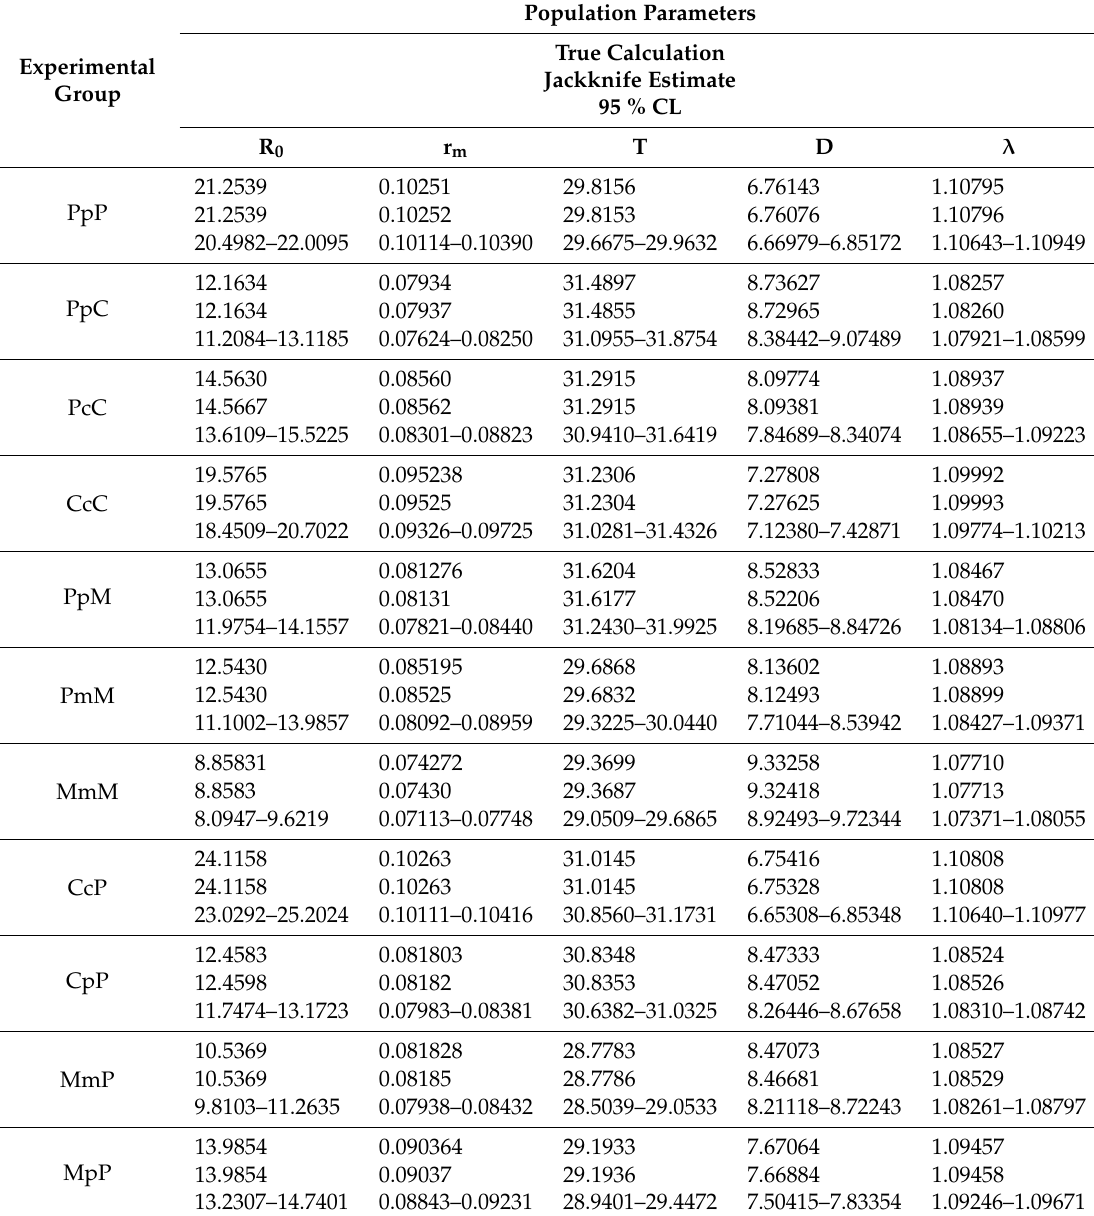
Table 2. True calculations, jackknife estimates and 95% CL for population parameters: The net reproductive rate (R 0 ), the intrinsic rate of increase (r m ), the mean generation time (T), the doubling time (D) and the finite rate of increase ( λ ) for each experimental